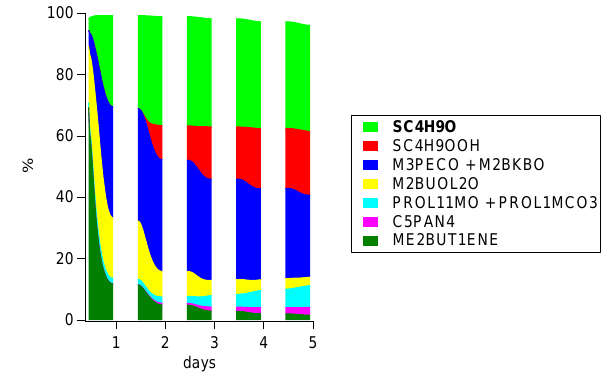
Fig. 8. Relative contribution of reaction pathways to the formation of MEK. See Fig. 9 for explanation of the MCM codenames.